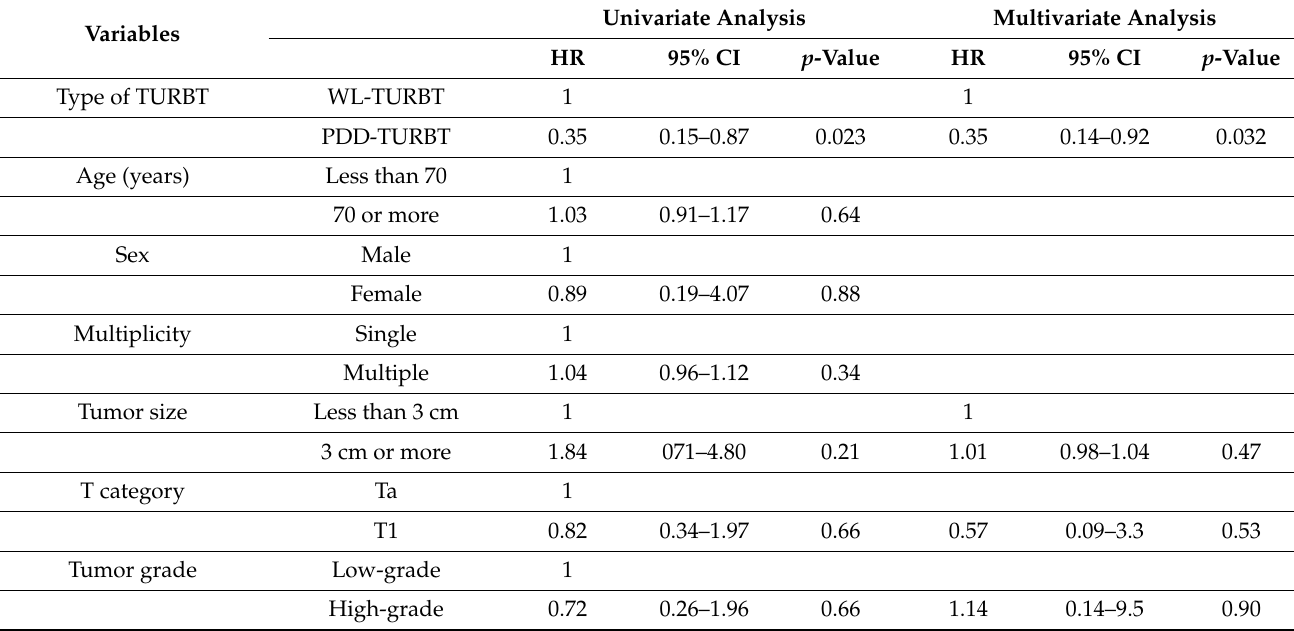
Figure 3. Recurrence-free survival curves of patients treated with white-light transurethral resection of bladder tumor (WL-TURBT) or photodynamic diagnosis (PDD)-assisted (TURBT). Table 2. Prognostic variables for recurrence-free survival after